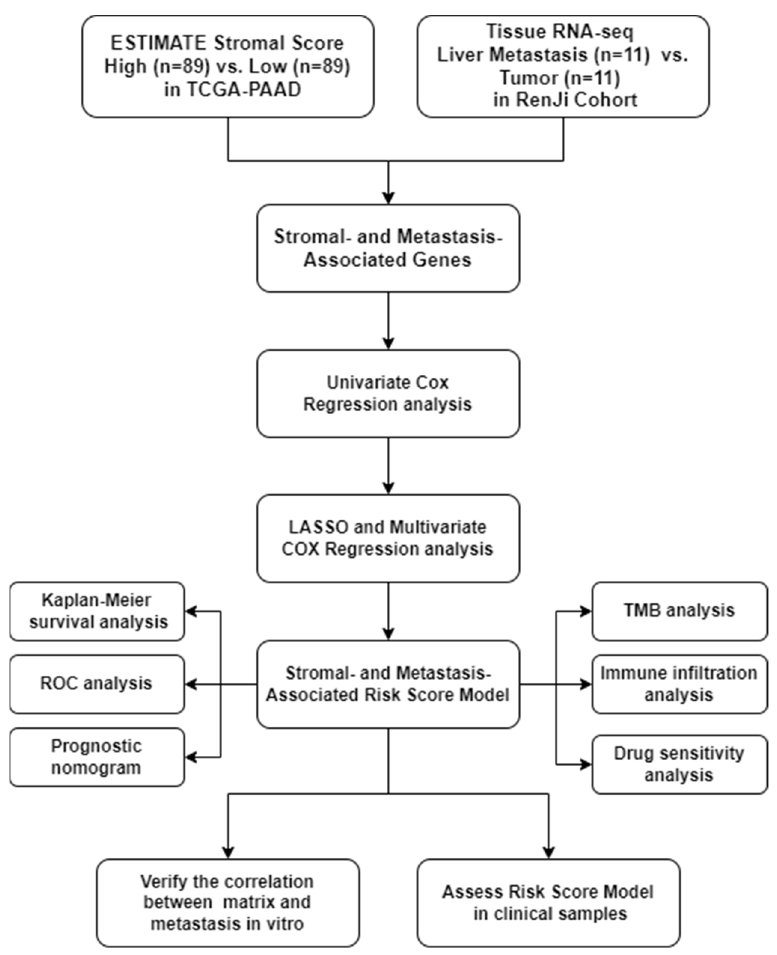
Figure 1. Workflow diagram of this study.